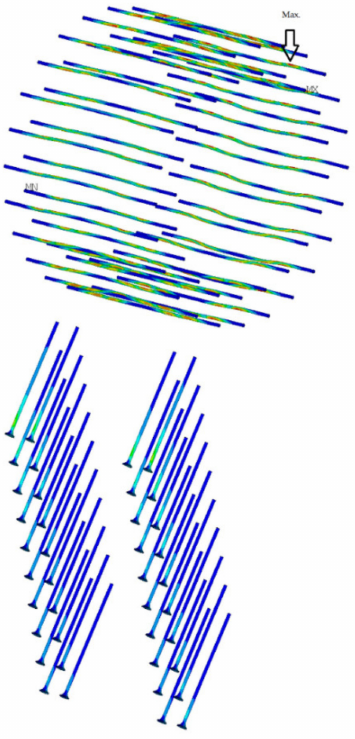
Figure 16. Connecting elements—max. stress.